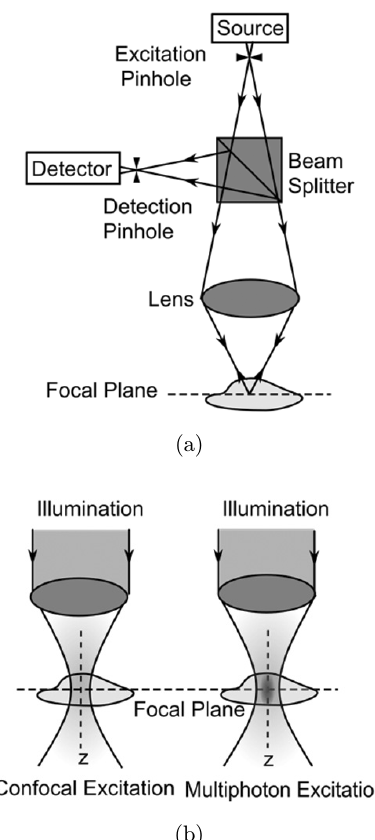
Fig. 1. The optical setup of (a) confocal system and (b) op- tical sectioning in confocal and multiphoton